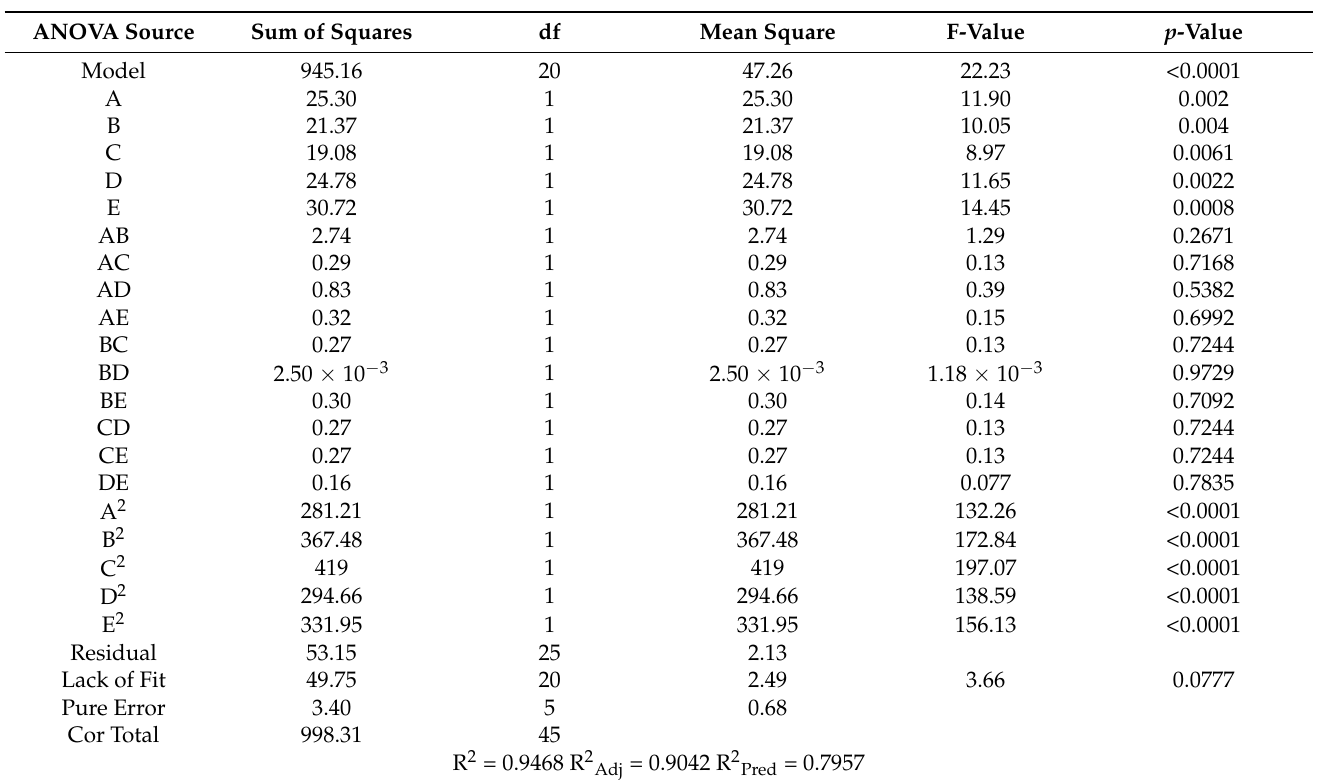
Table 2. ANOVA of